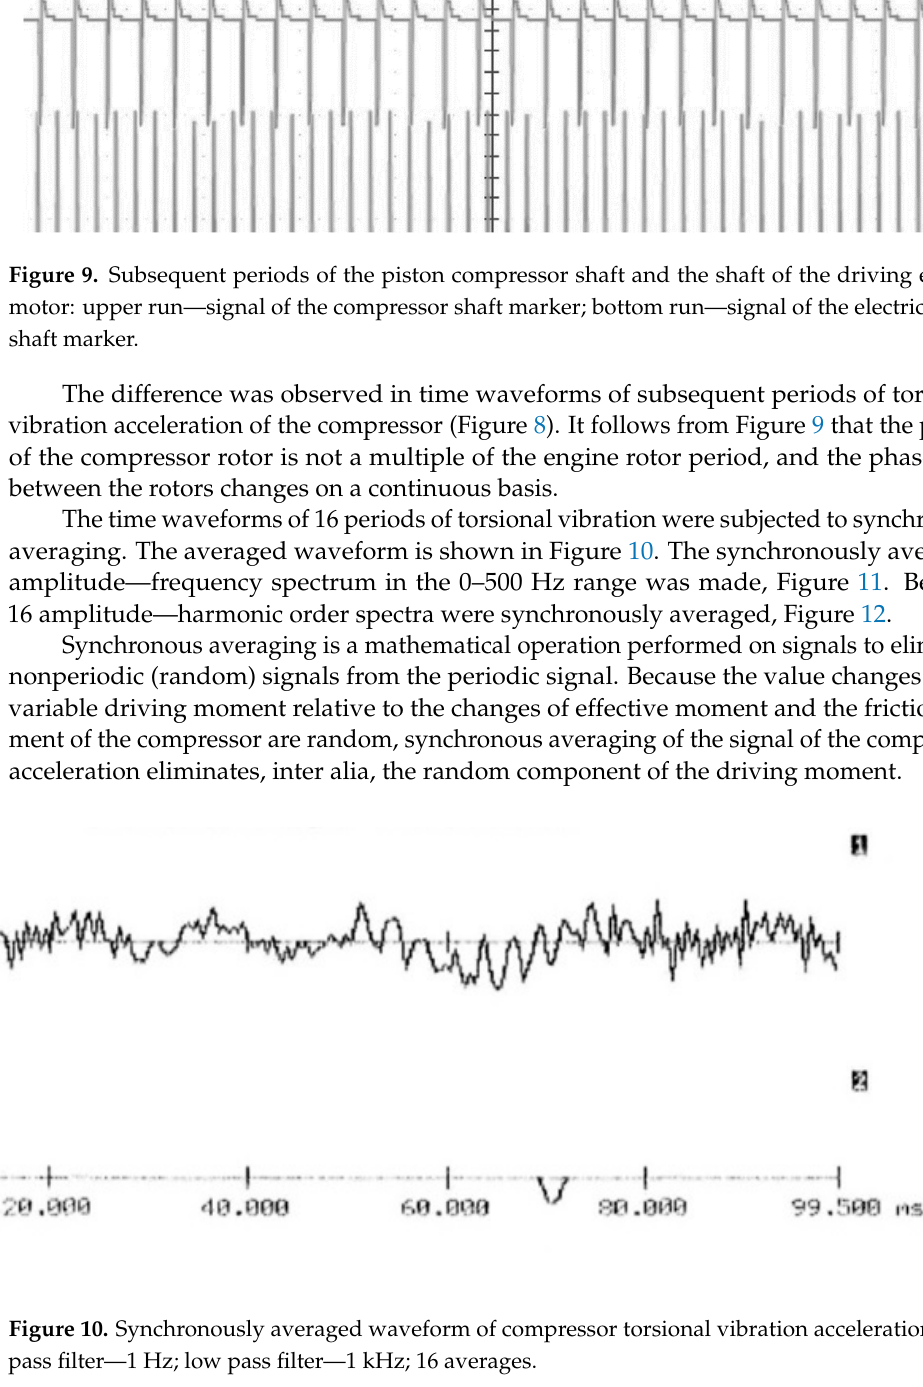
Figure 8. Time waveforms of the signals: upper run—waveform of the compressor shaft marker; bottom run—torsional vibration acceleration of the piston compressor free end.